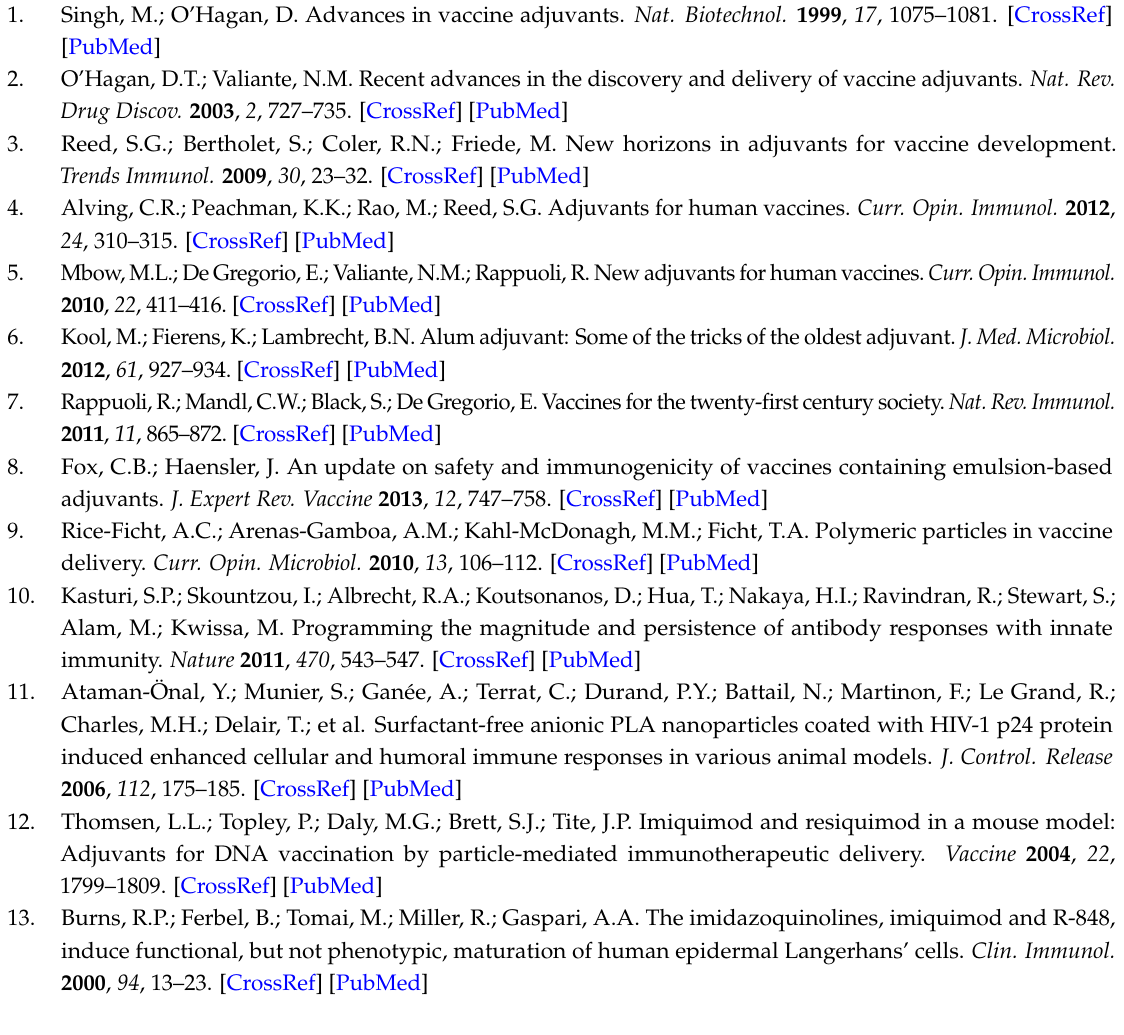
Figure S1: In vitro cytotoxicity of micelleplexes after 24 h incubation at different N:P ratios determined by MTT assay against DC 2.4 cells ( n =